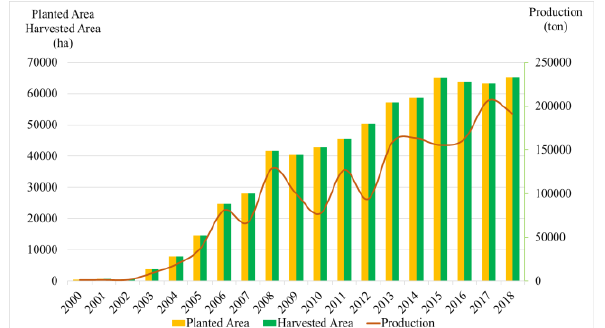
Figure 2. Evolution of areas destined for agricultural production from 2000 to 2018 in the Chapadinha microregion. Source: IBGE (2019).